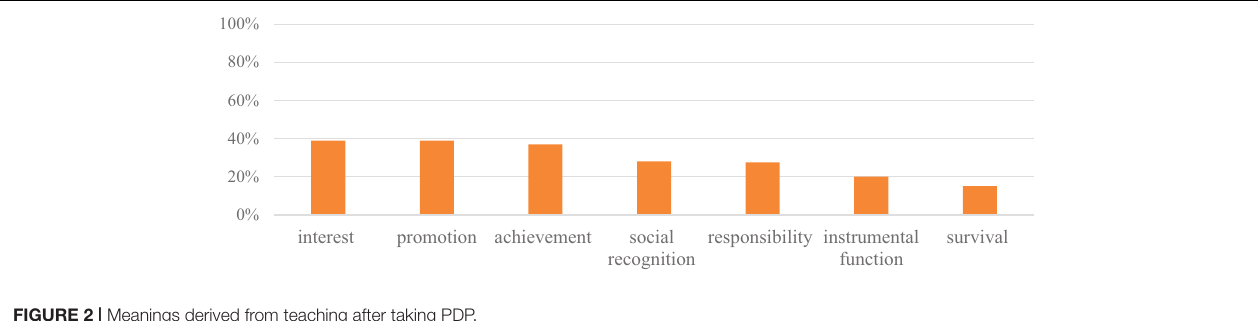
FIGURE 2 | Meanings derived from teaching after taking